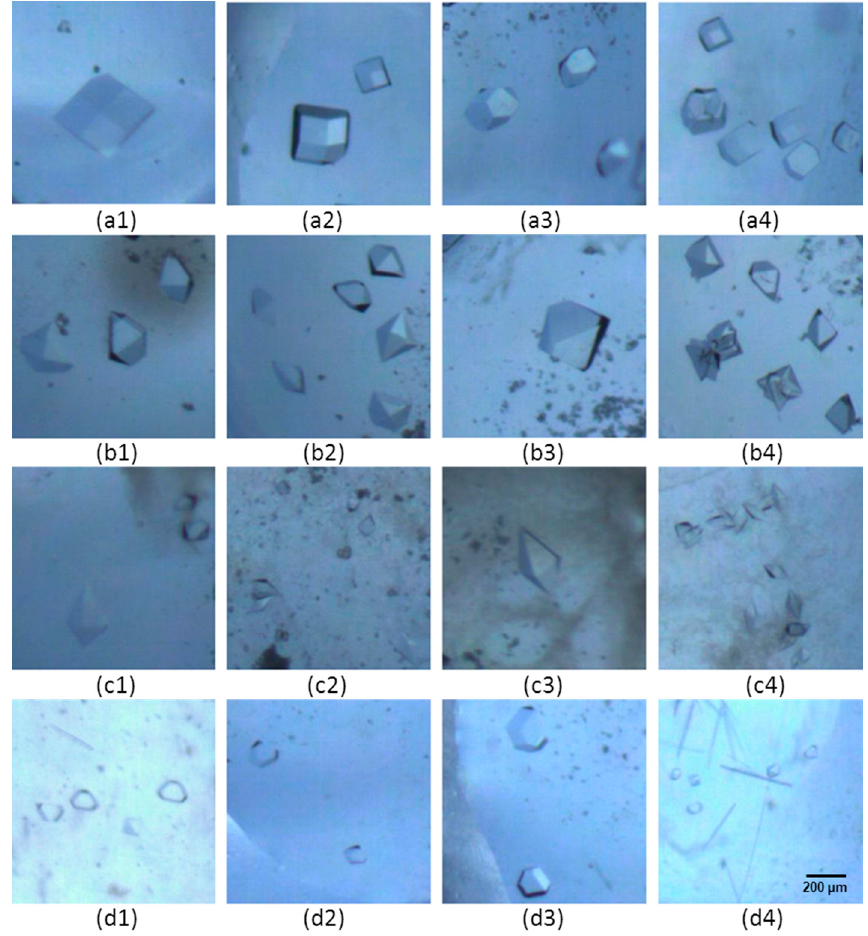
Figure 1. Some typical images of the crystal morphologies obtained in the presence and absence of CLPC seeds. ( a1 – d1 ) in the presence of seeds 1, ( a2 – d2 ) in the presence of seeds 2, ( a3 – d3 ) in the presence of seeds 3, ( a4 – d4 ) in the absence of seed, ( a1 – a4 ) Lysozyme, ( b1 – b4 ) proteinase K, ( c1 – c4 ) thaumatin, ( d1 – d4 ) glucose isomerase.